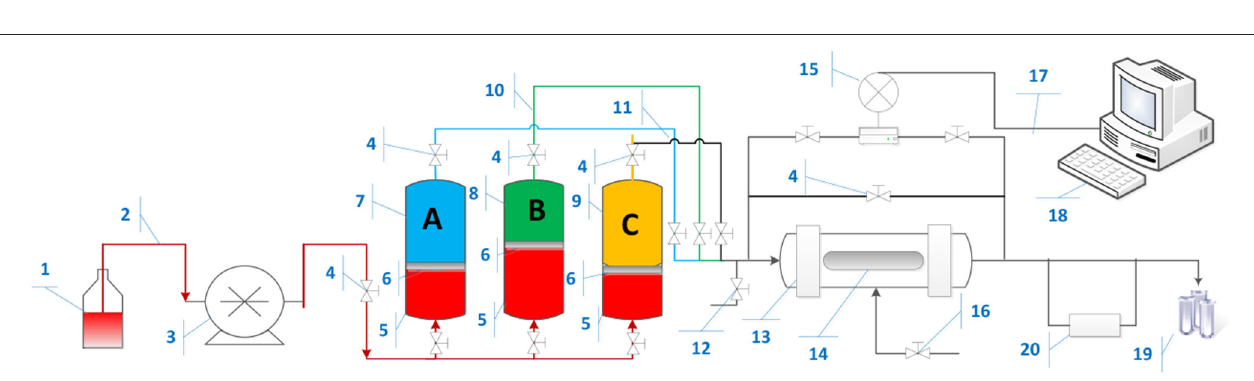
Frontiers in Physics |